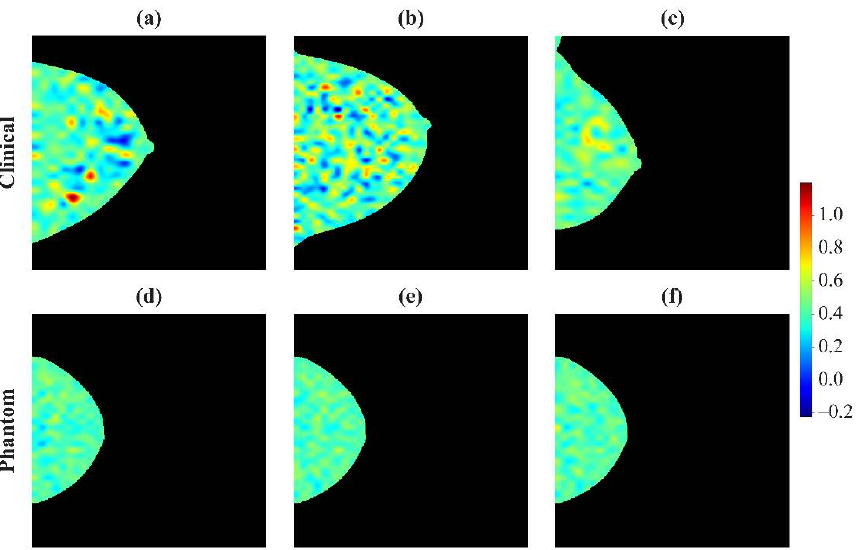
Figure 6. Heat maps for a non-robust feature (a Laws feature, CMV = 1.43) used as an example in Figure 1b. Top row: Heat maps derived from patients at the ( a ) 5th, ( b ) 50th, and ( c ) 95th percentiles of the distribution in Figure 1b. Bottom row: Heat maps illustrating how this feature is affected by variations in the imaging acquisition parameters, i.e., the ( d ) left-most, ( e ) intermediate, and ( f ) right-most data points in Figure 1b. Similar to Figure 5, these heat maps are smoothed to avoid artifacts of pixelation.